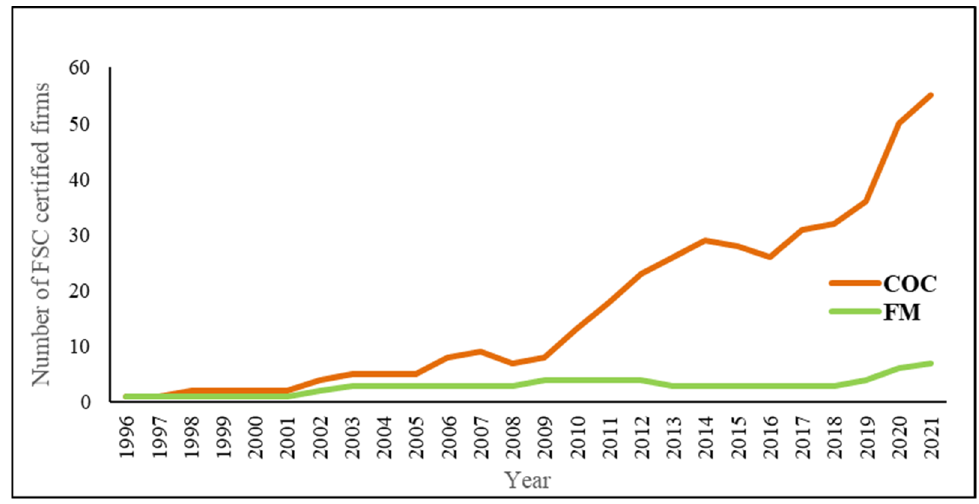
Figure 1. Growth of FSC certification in Sri Lanka (1996 to 2021). Source: [12].